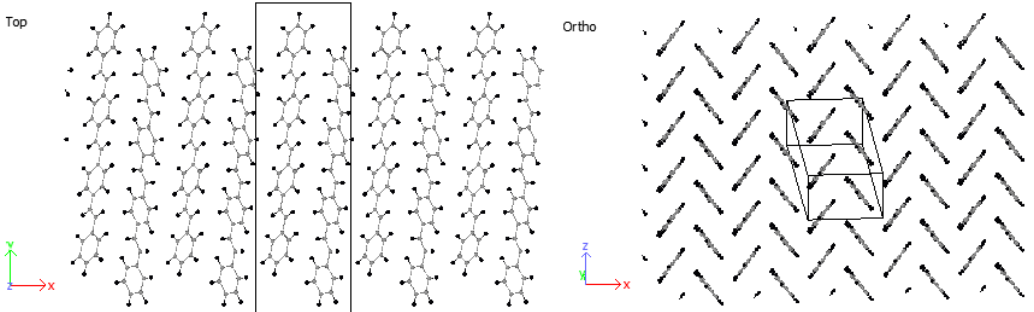
Molecules 2020 , 25 , x FOR PEER REVIEW Figure 12. Three-PPV oligomer chains (3PPV) HB-packing from simulation. Figure 12. Three-PPV oligomer chains (3PPV) HB-packing from simulation.